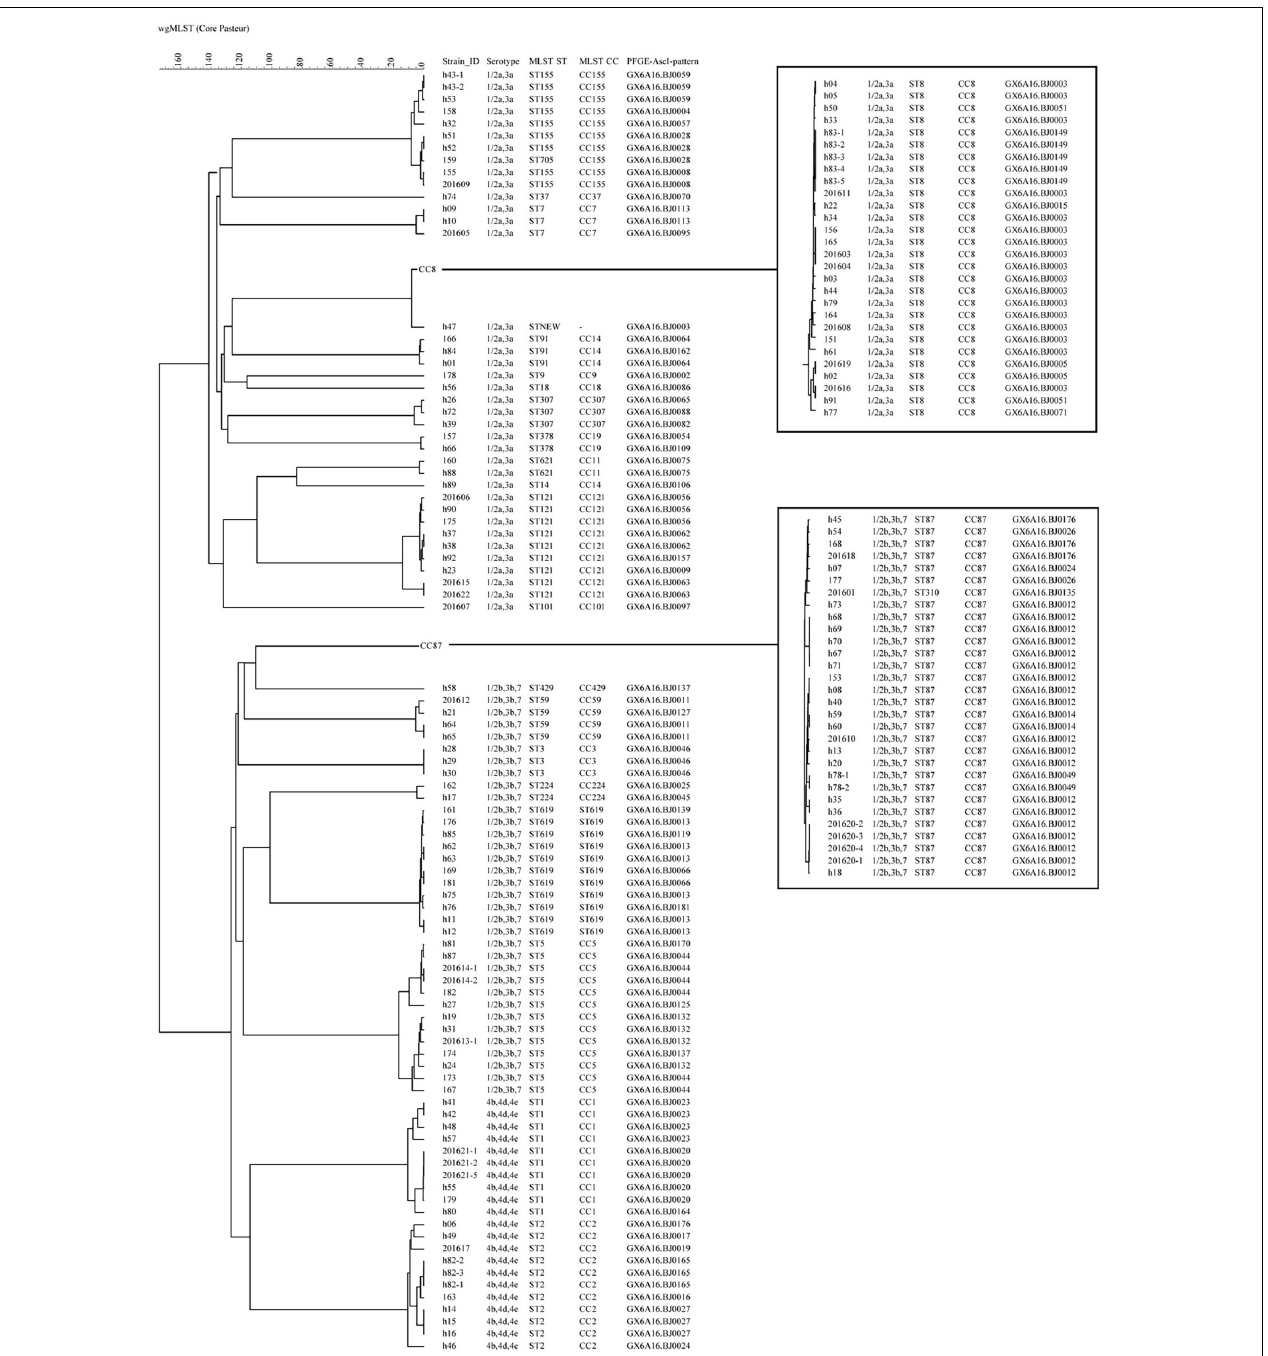
FIGURE 2 | The phylogenomic tree of 151 L. monocytogenes isolates based on cgMLST (Core-genome MLST) ( n = 1,748). The corresponding data, including the name of the isolates (Strain ID), serogroups, MLST type (ST), MLST clonal complexes (CC), PFGE types (PT), were shown alongside the dendrogram to the